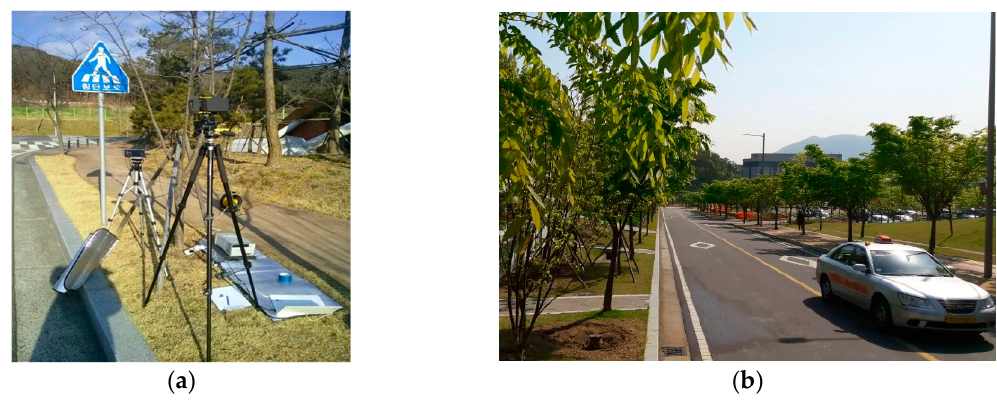
Figure 7. Radar installation for roadside surveillance: ( a ) Radar with stand holder; ( b ) target road and vehicle.